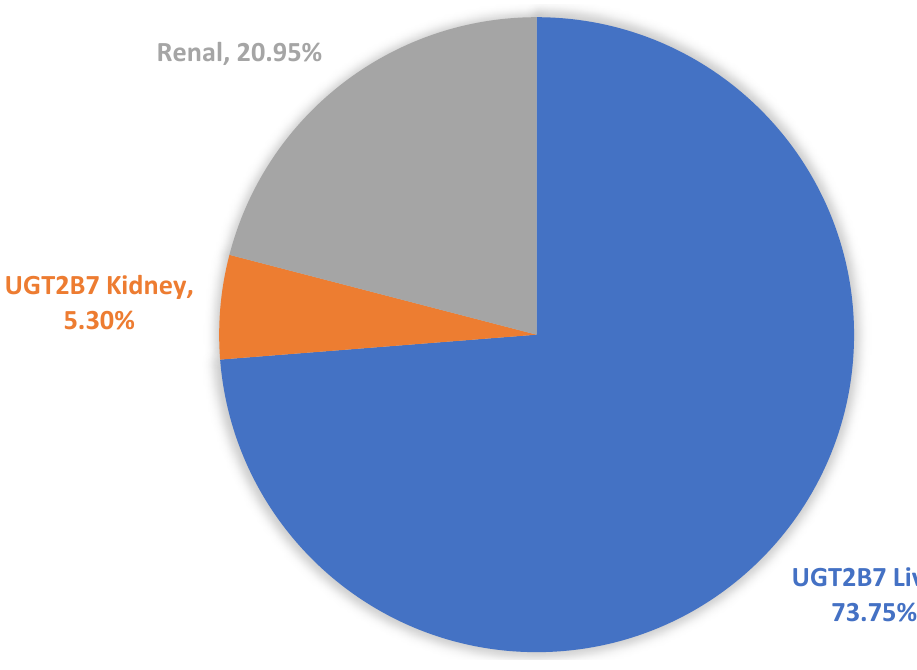
Figure 3. A representative pie-chart showing the relative contribution (geometric mean %) of the f m (hepatic and renal epirubicin) and the f e unchanged by renal clearance.